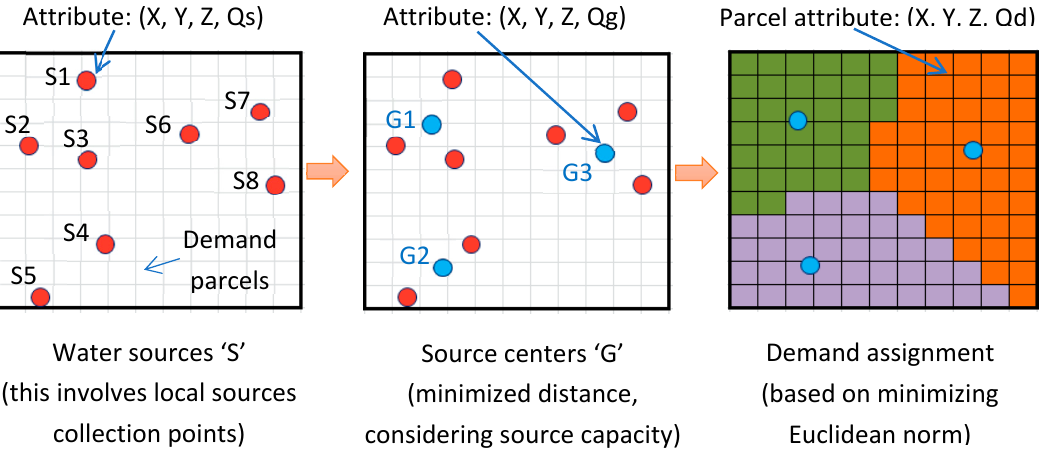
Figure 2. Assignment of parcels to the source center. (X, and Y are location parameters, Z is elevation above sea level (asl), Qd is parcel demand, Qs and Qg are capacity of local water sources and group source respectively).